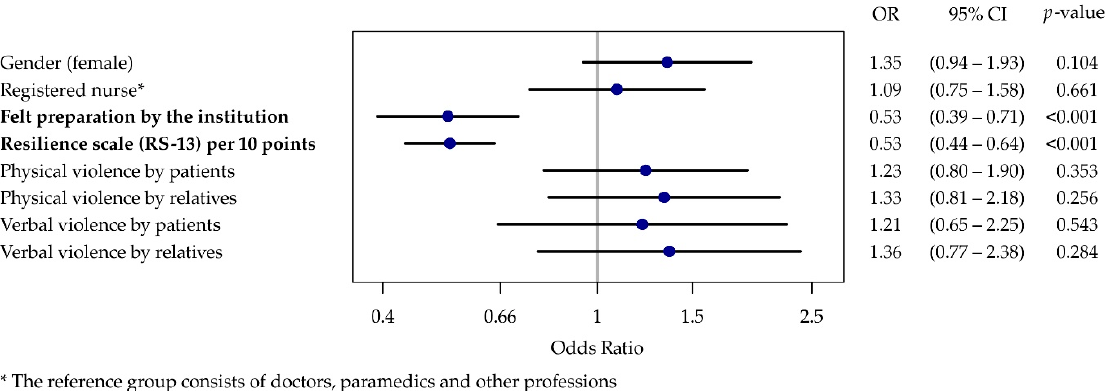
Figure 2. Forest plot of the ordinal regression results for work-related burnout.